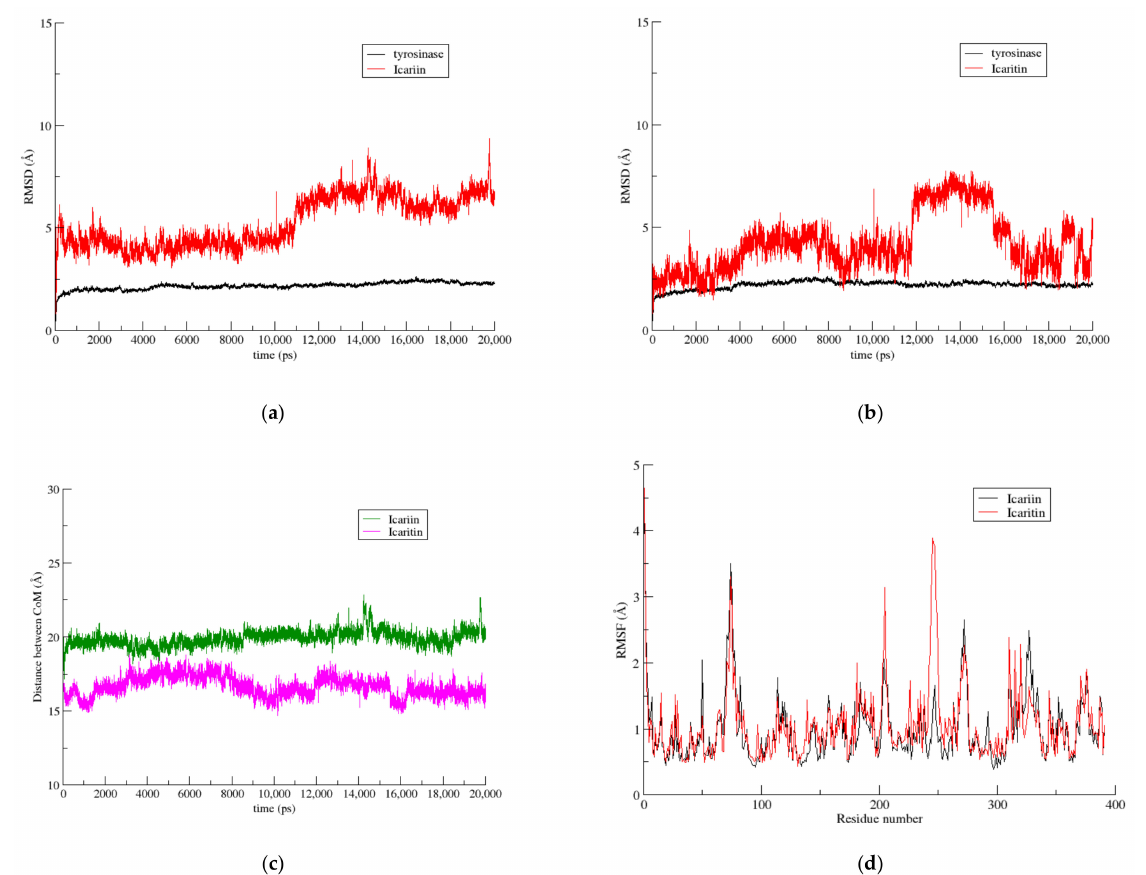
Figure 4. RMSD vs. time for all atoms in ( a ) icariin and ( b ) icaritin (aglycone) complexes with tyrosinase as a function of simulation time, ( c ) COM plot of tyrosinase in complex with icariin and icaritin, and ( d ) RMSF plot of tyrosinase residues in their complexes with icariin and